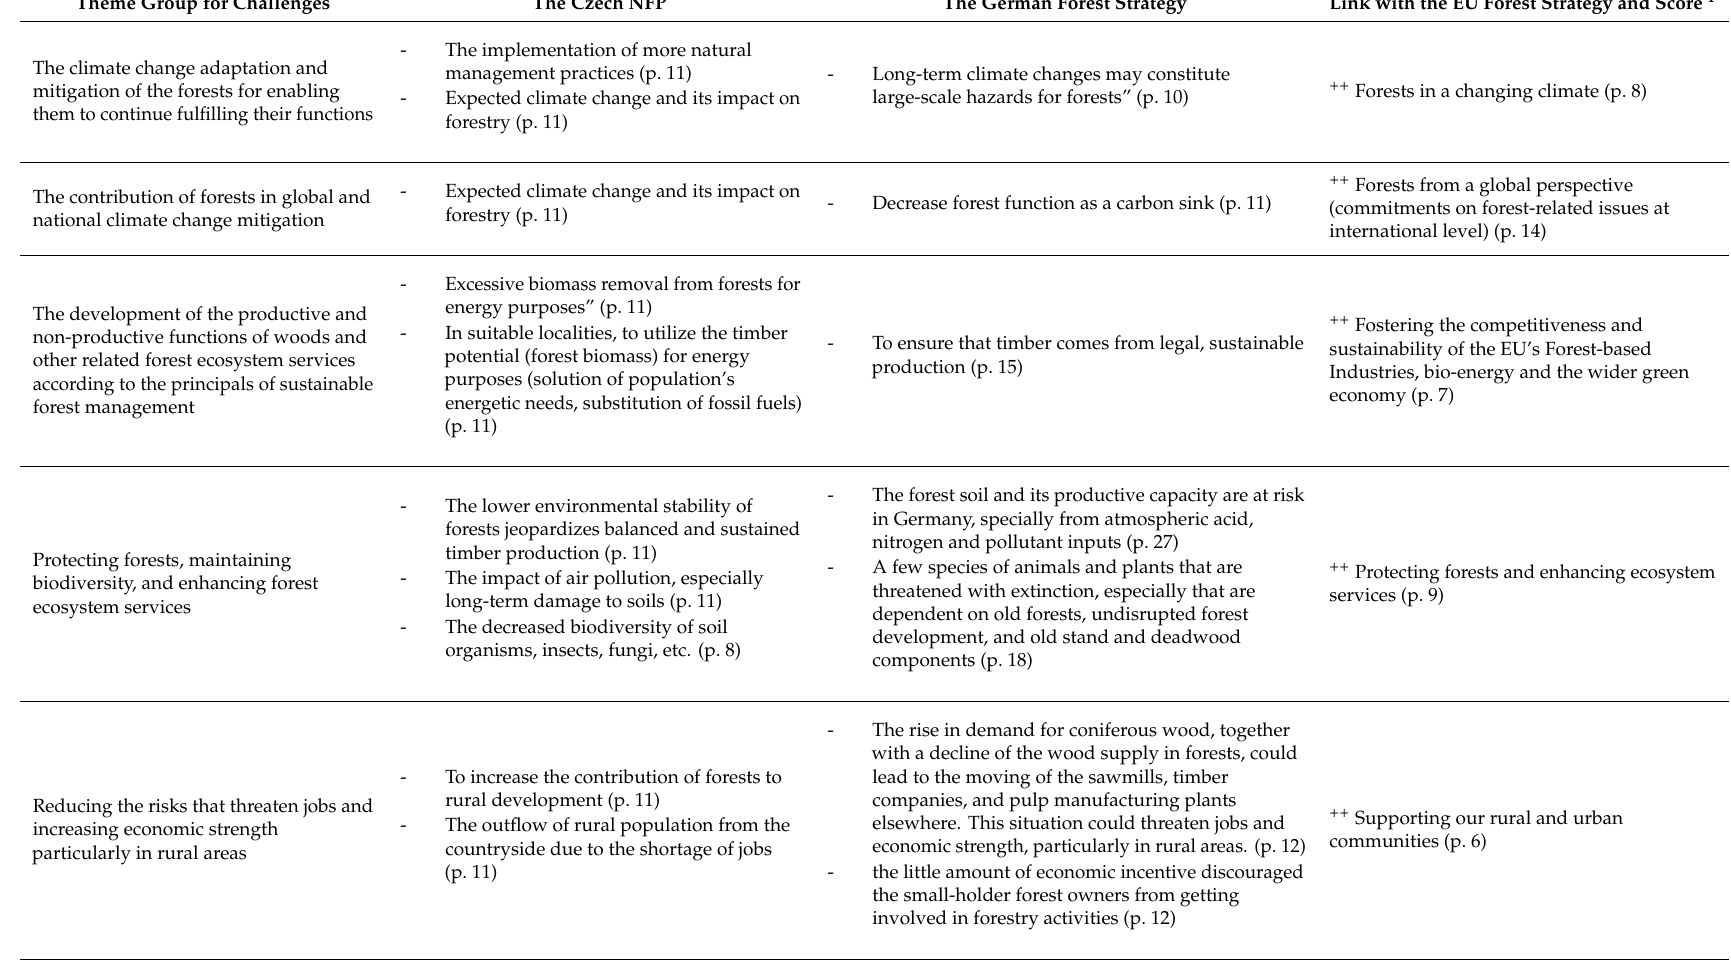
Table A3. Challenges related to wood forest production and consumption in the Czech Republic and Germany based on the studied national forest strategies. Theme Group for